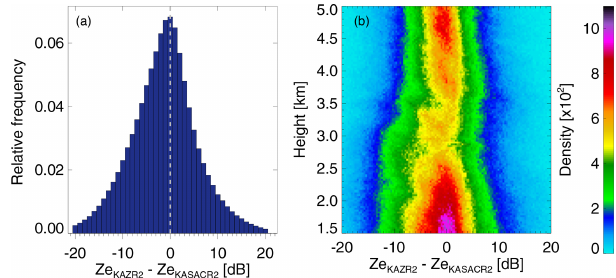
Figure 3. For the period when KAZR2 and KaSACR2 are matched in time and range: (a) difference in radar reflectivity reported by both sensors over the ranges between 1.5 and 5.0km and the (b) dif- ference in radar reflectivity reported by both sensors as a function of